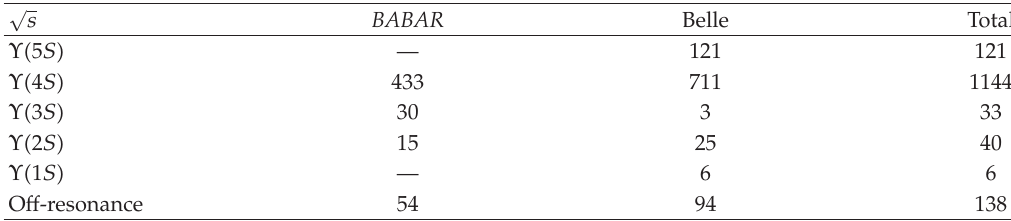
Table 1: Integrated luminosities (cid:2) fb − 1 (cid:3) collected by the B factories at di ff erent center-of-mass energies. The o ff -resonance data were collected about 40MeV below the Υ(cid:2) 4 S (cid:3) resonance at BABAR and at a similar o ff set for the Υ(cid:2) 4 S (cid:3) and Υ(cid:2) 5 S (cid:3) resonances in the case of Belle.